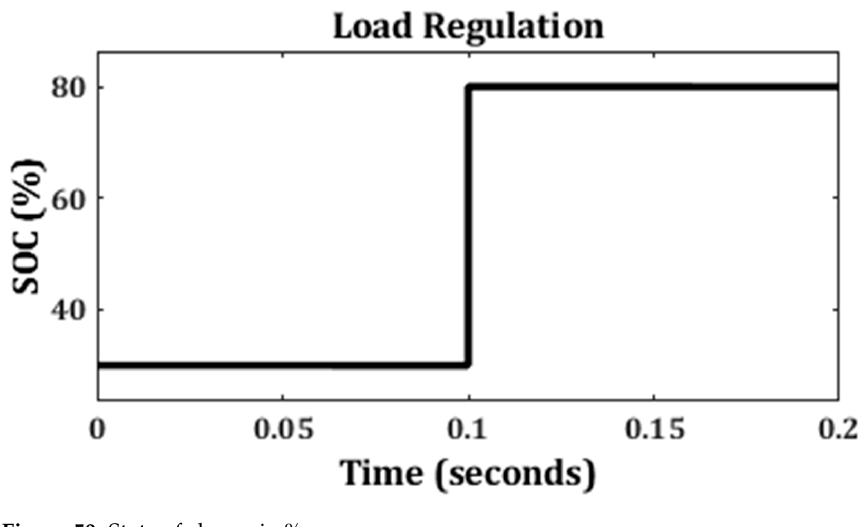
Figure 49. Battery terminal voltage in volts.